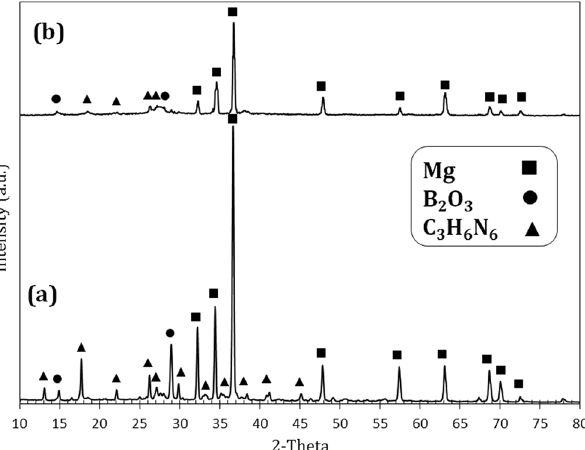
Figure 1. X-ray diffraction patterns of the ( a ) initial mixture and ( b ) 15 min-milled powders in M10 sample.